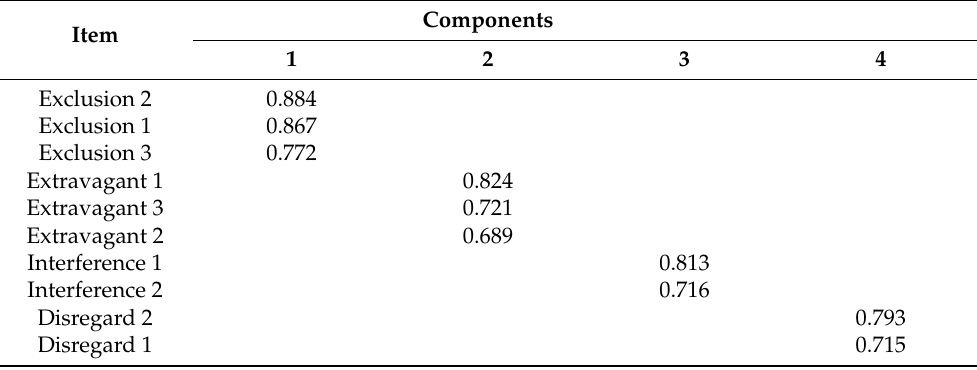
Table 2. Factor loading matrix after orthogonal rotation of the dependent variable.